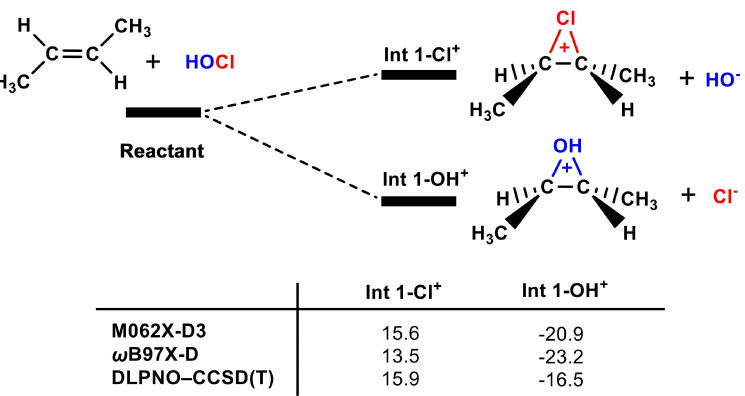
Figure 4. The Gibbs free energies of Int 1-OH + and Int 1-Cl + according to different methods are included (in kcal mol − 1 ).